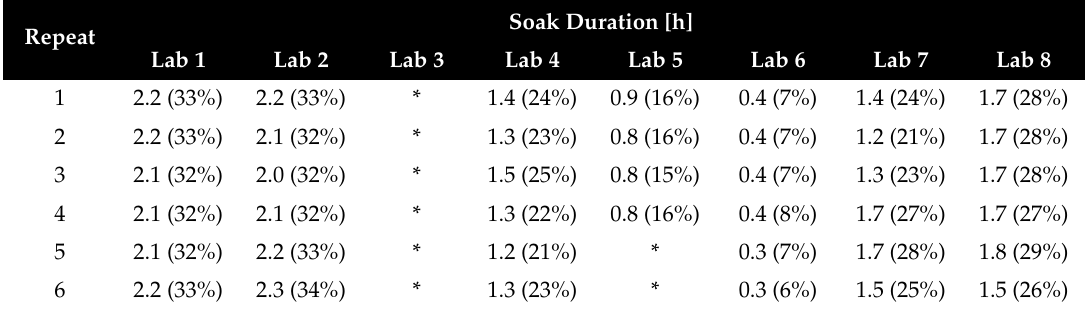
Table 7. Soak times required by di ff erent labs in all six repetitions of T1—values in parenthesis represent the percentage (%) of soak time relative to the entire duration of the cycle. (*) denotes missing data. Soak Duration [h] Repeat Lab 1 Lab 2 Lab